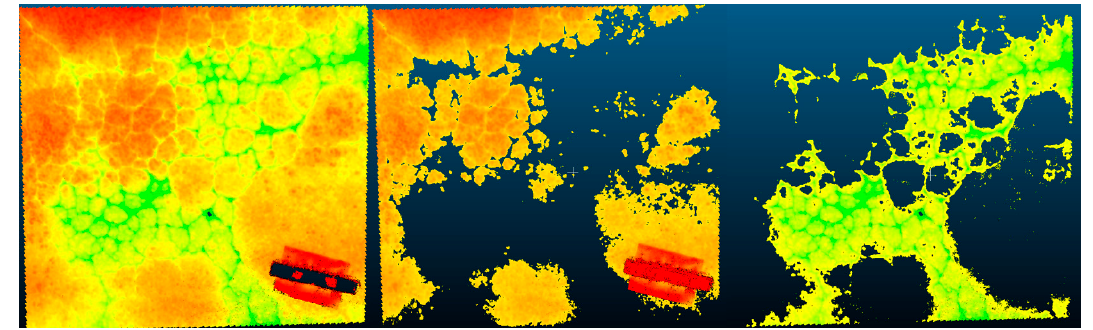
Figure 30. Segmented pavement section 2 using fit plane.